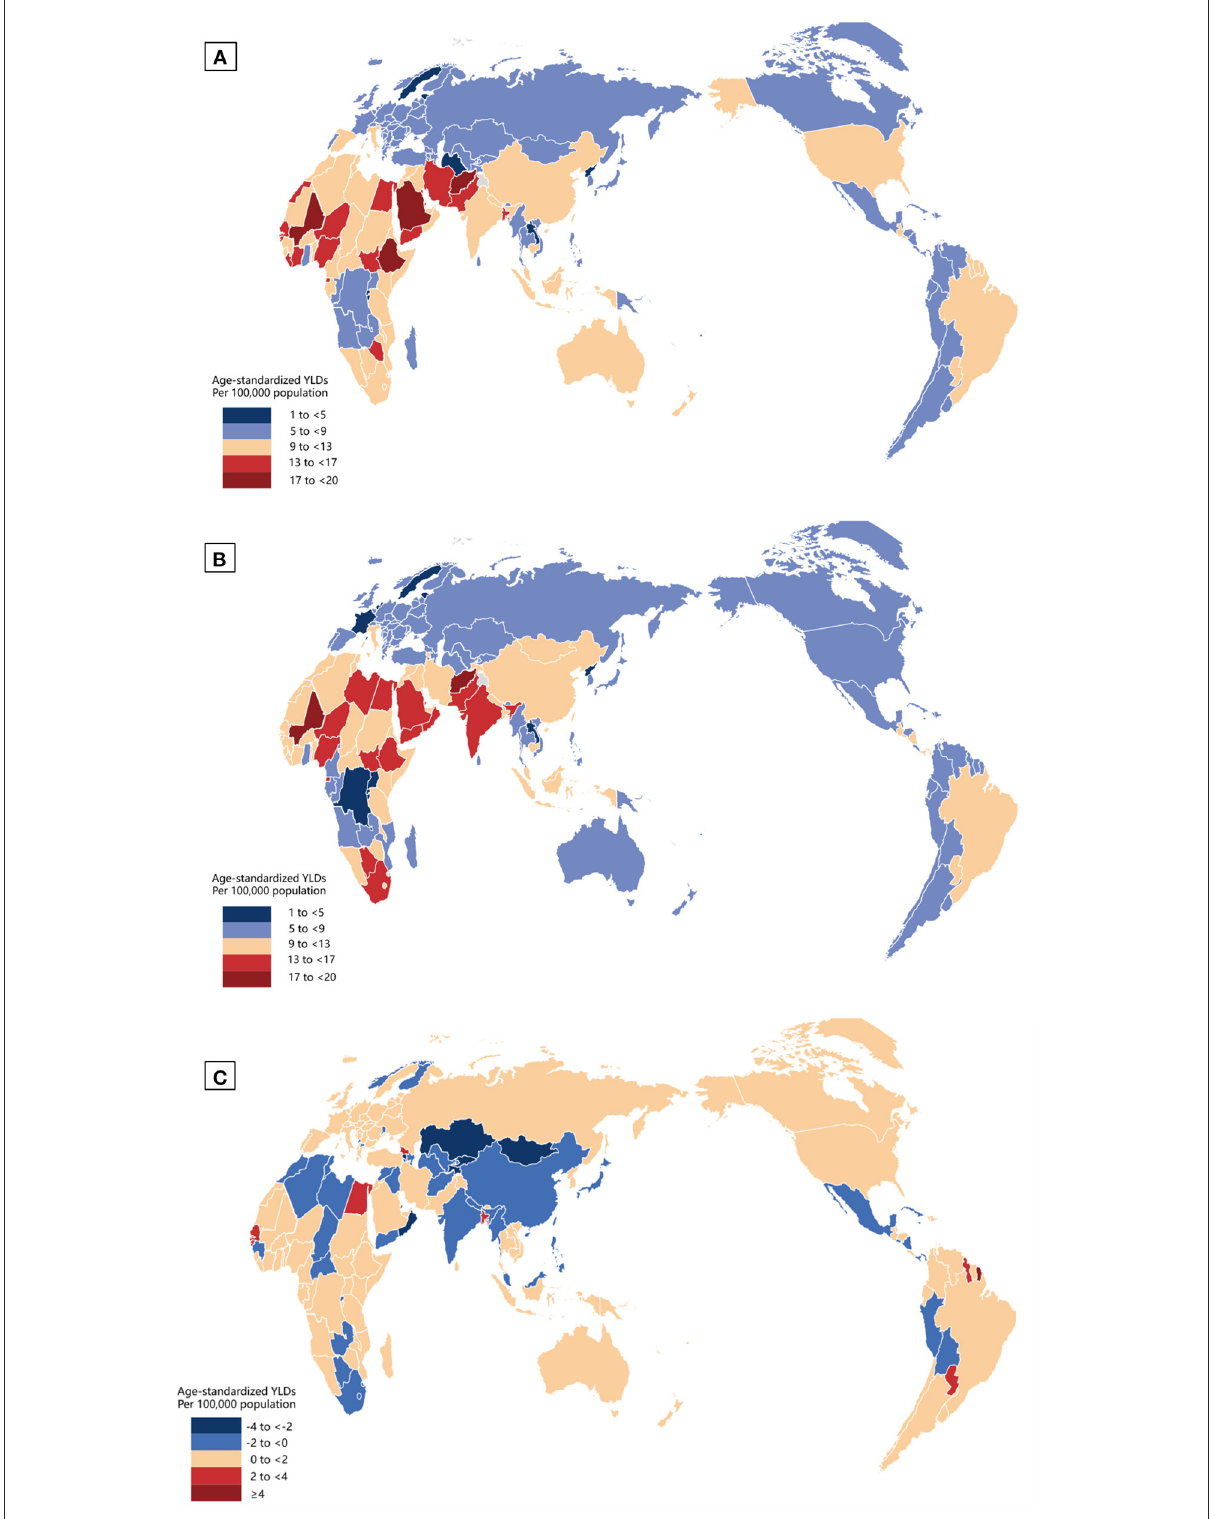
FIGURE2 Global map of NPB-related vision impairment burden by sex in 2019. Geographic distribution of age-standardized YLDs per 100,000 population in nations with NPB-related vision impairment in 2019; female (A) , male (B) , and female minus male (C) . NPB, Neonatal preterm birth; YLDs, years lived with